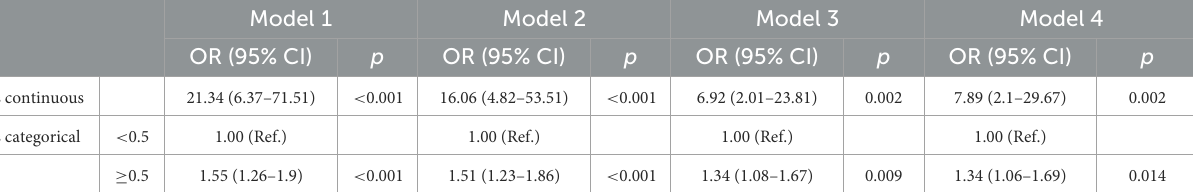
TABLE 3 Association between WHtR and new-onset hypertension in logistics regression.